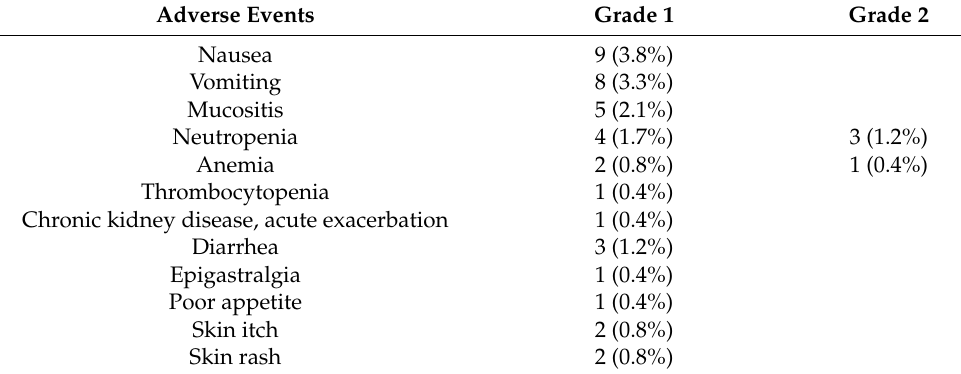
Table 2. Adverse effects of tegafur–uracil ( n = 96).